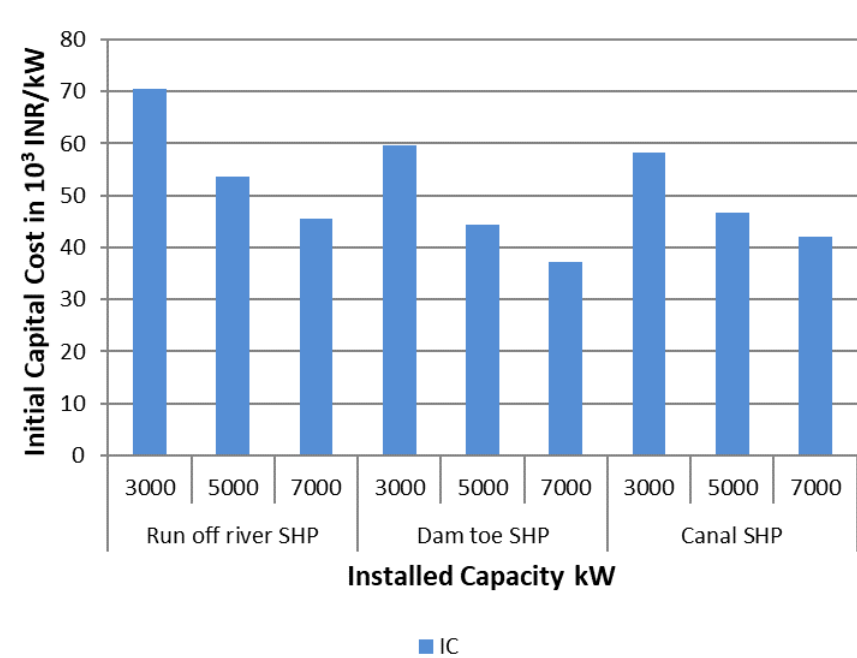
Figure 4. Variation of IC vs. LCC w.r.t head for 2000 kW plant.